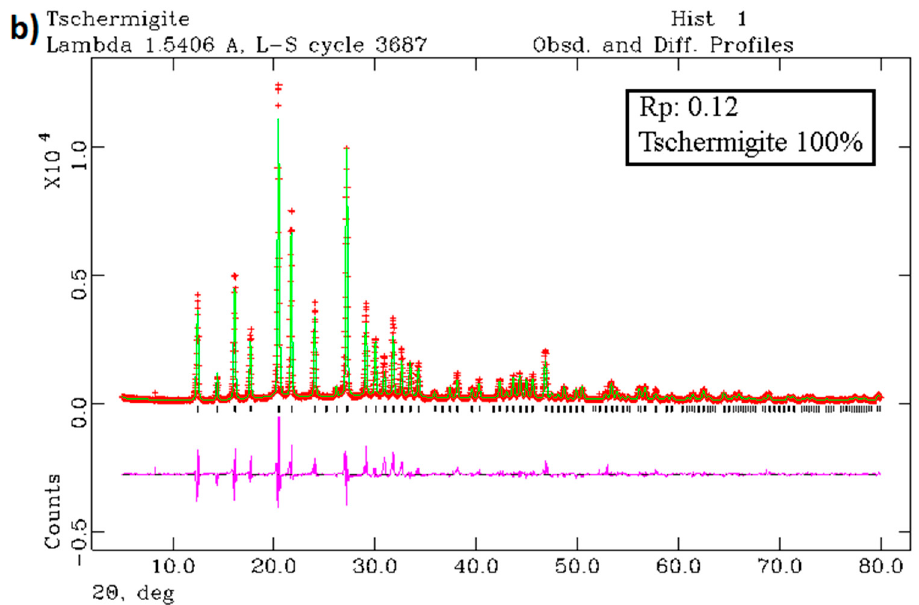
Figure 5. ( a ) Crystal structure of tschermigite. In yellow, the S tetrahedra, red, pink, blue and orange balls represent oxygen, water molecules, NH 4 groups and Al octahedra, respectively. ( b ) The X-ray diffraction spectrum of the sample indicated as tschermigite refined with the Rietveld method [50], using GSAS EXPGUI [51,52] software.